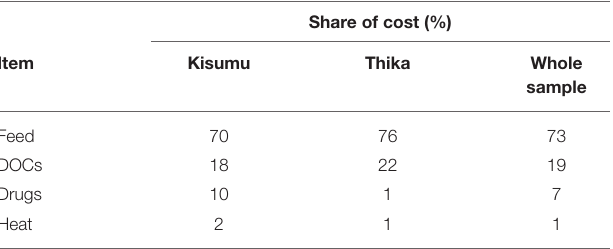
TABLE 6 | Shares of different costs in indigenous chicken farming in Kisumu and Thika, 2016.